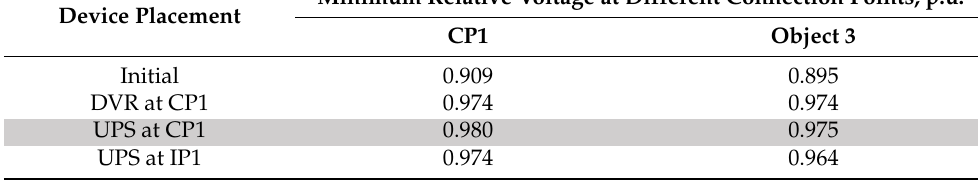
Table 7. Comparison of solutions for Object